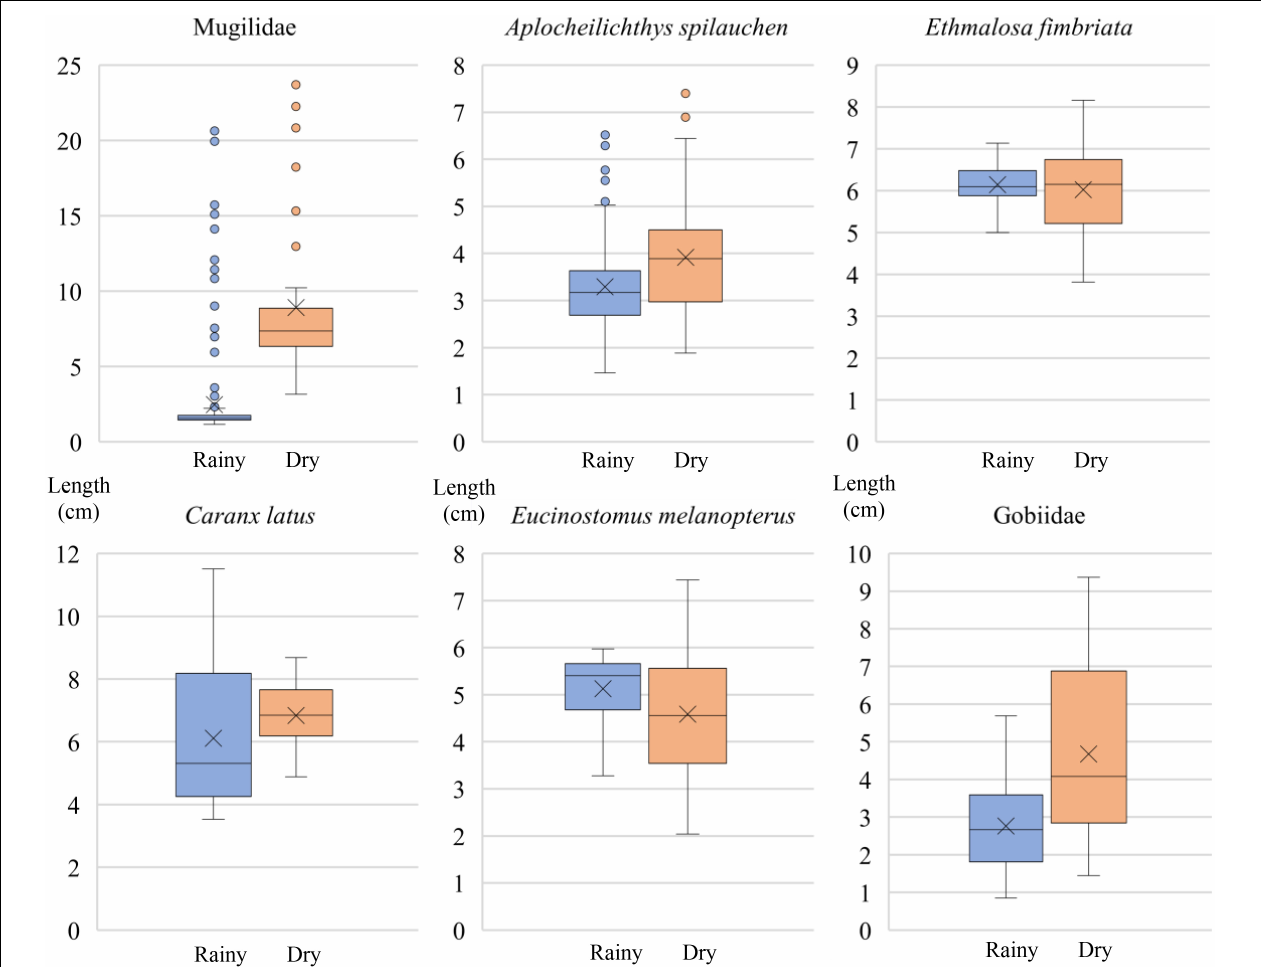
FIGURE 4 | Fish lengths (TL), during the rainy and dry seasons. The boxplots represent the four quartiles of the data and the “X” the mean. The outliers represent a data point that exceeds 1.5 times the interquartile range (IQR) from the top or bottom of the box.